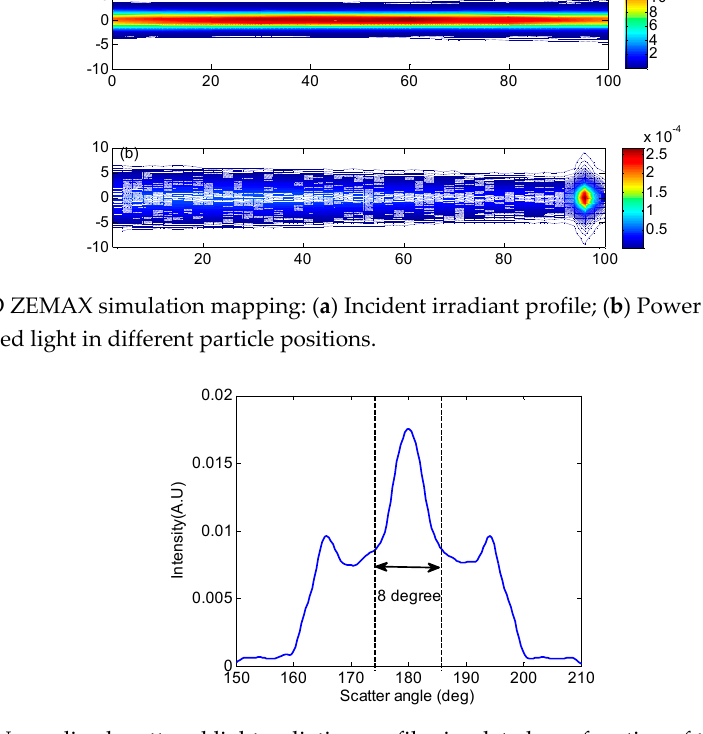
Figure 3. Normalized scattered light radiation profile simulated as a function of the scatter angle.